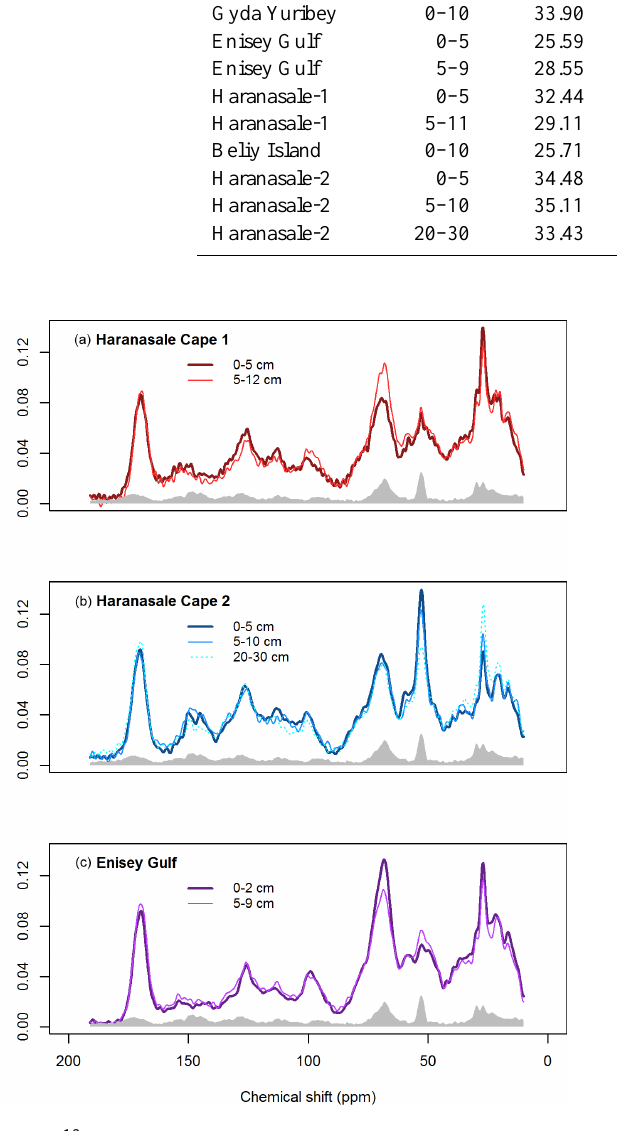
Figure 5. 13 C-NMR spectra at different soil depths. The grey spec- trum corresponds to the standard deviation of all 13 C-NMR